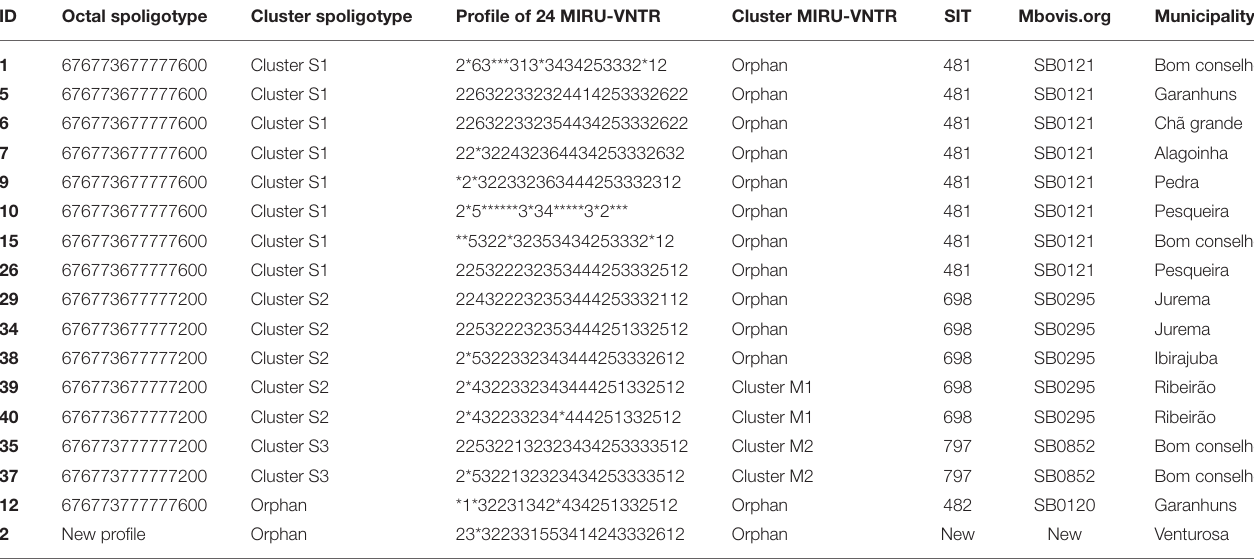
TABLE 1 | Molecular characterization of M. bovis isolates from cattle in the state of pernambuco by Spoligotyping and MIRU-VNTR. ID